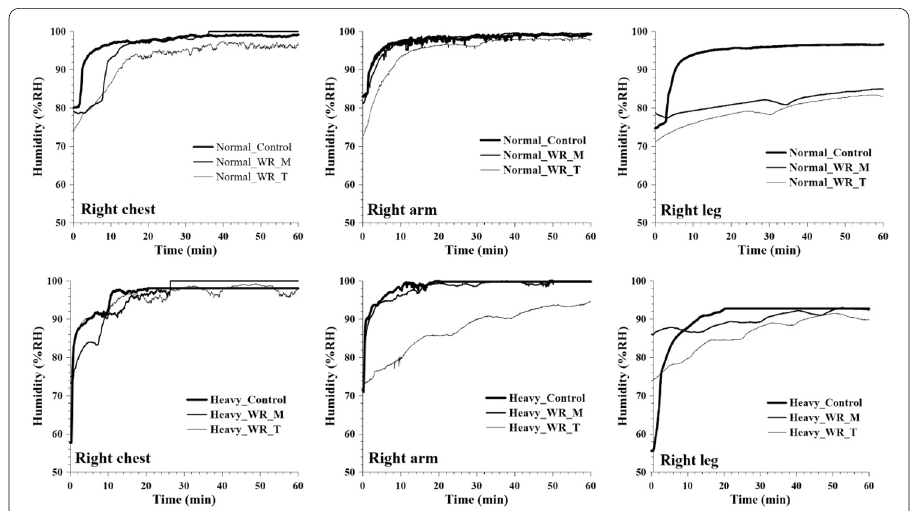
Fig. 3 Time courses of microclimate humidity when wearing combat uniforms with no washes